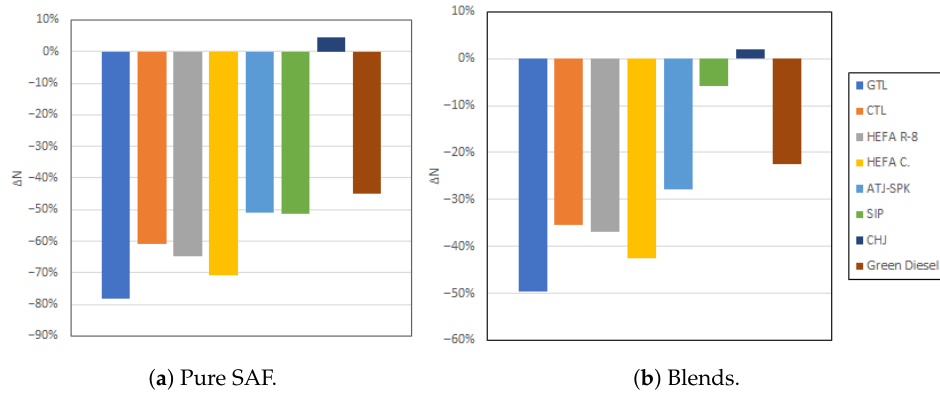
Figure 8. MRDs in particle number emissions.